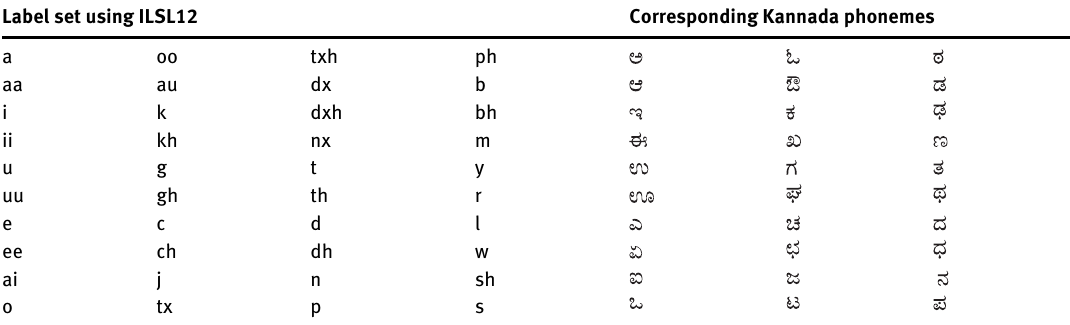
Table 15: The Labels Used from ILSL12 for Kannada Phonemes. Label set using